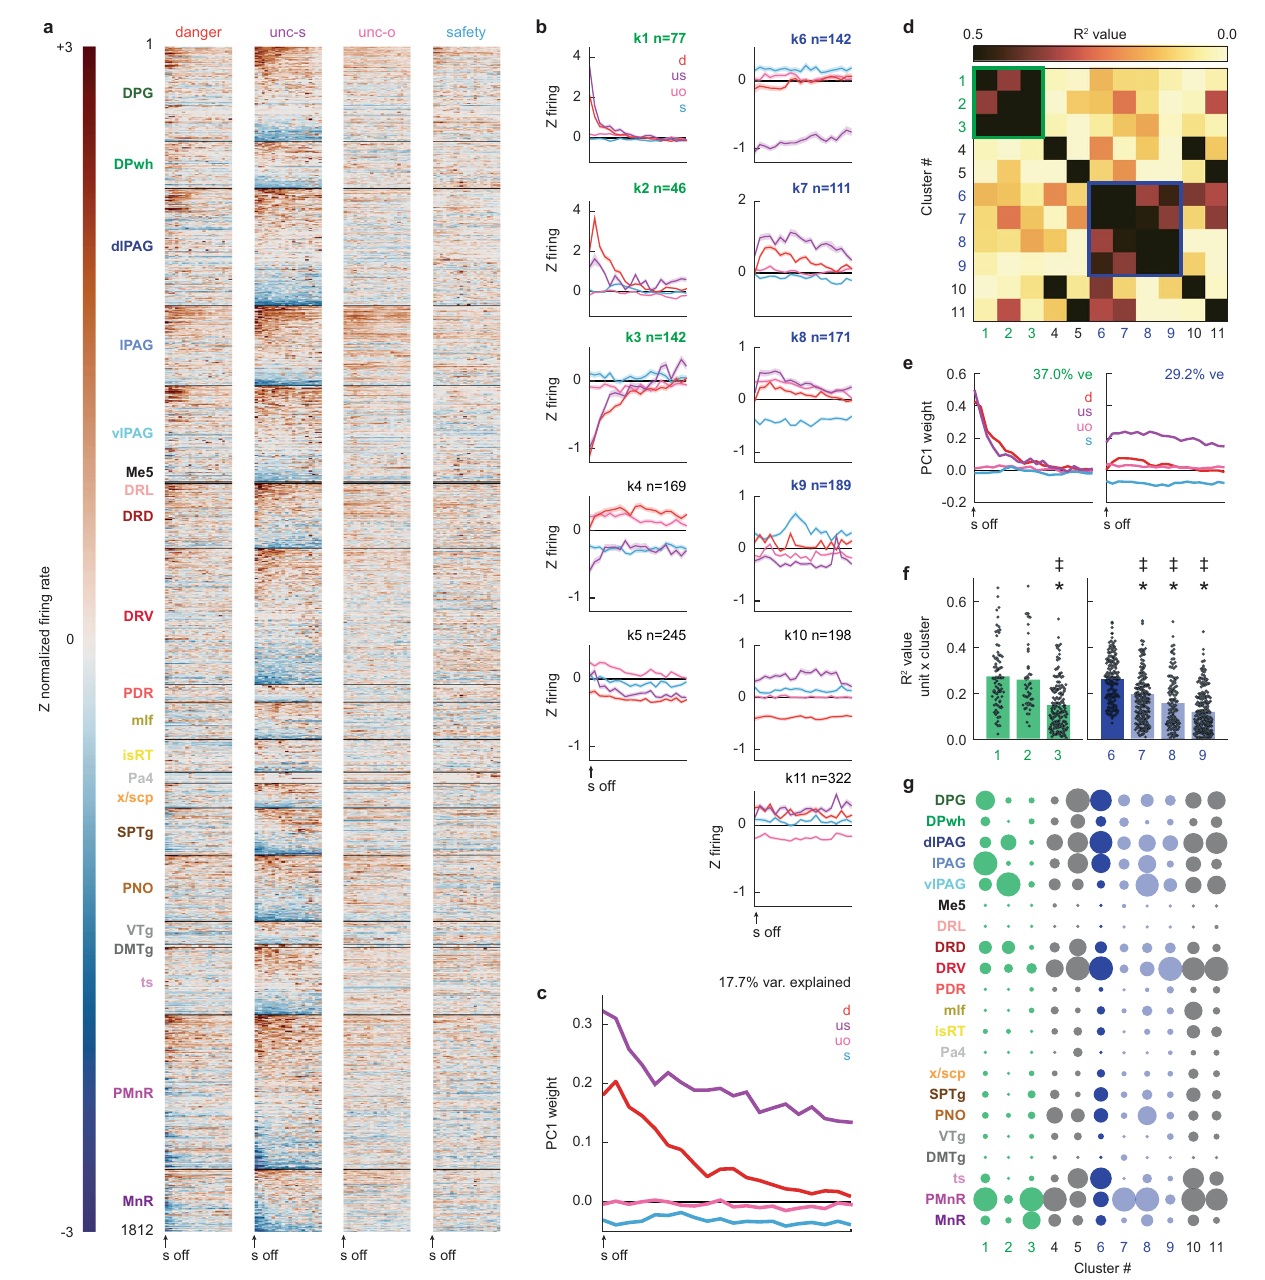
Fig. 4 | Brainstem outcome fi ring. a Single-unit fi ring (n-1812) following danger, uncertainty shock, uncertainty omission, and safety organized by brain region, dorsalto ventral. b Meancluster (k1 – k11) fi ring following shock(cluster n shownin the fi gure). c PC1 for brainstem outcome fi ring. d Between-cluster cue fi ring cor- relations (data from b ). Phasic outcome network outlined in green, tonic outcome network outlined in blue. e PC1 for phasic outcome network fi ring (left), and tonic outcome network fi ring (right). f Single unit × cluster fi ring correlations for the